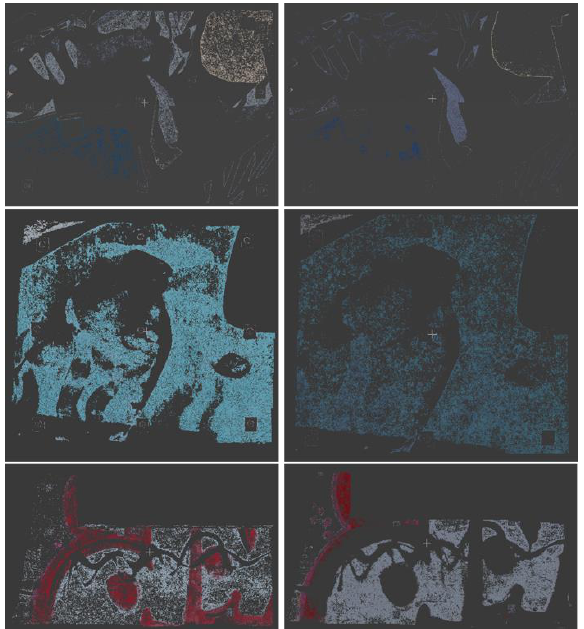
Figure 7: "Blue", “Green” and “Red” Classified Points from the Athena, Mermaid and Random Red graffities point clouds of Bayer (Left) and FOVEON (Right)